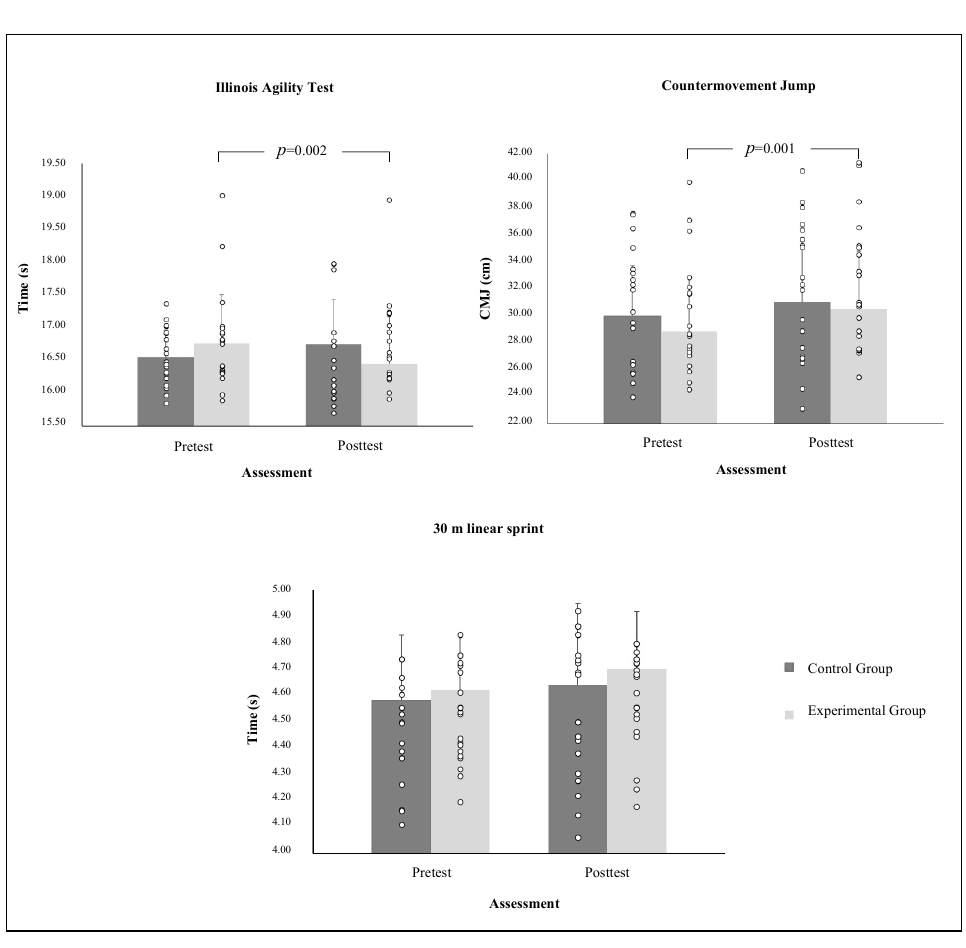
Figure 1. Performance variables before (preintervention) and after (postintervention) study period: a within- and between-group comparison. CG, control group; EG, experimental